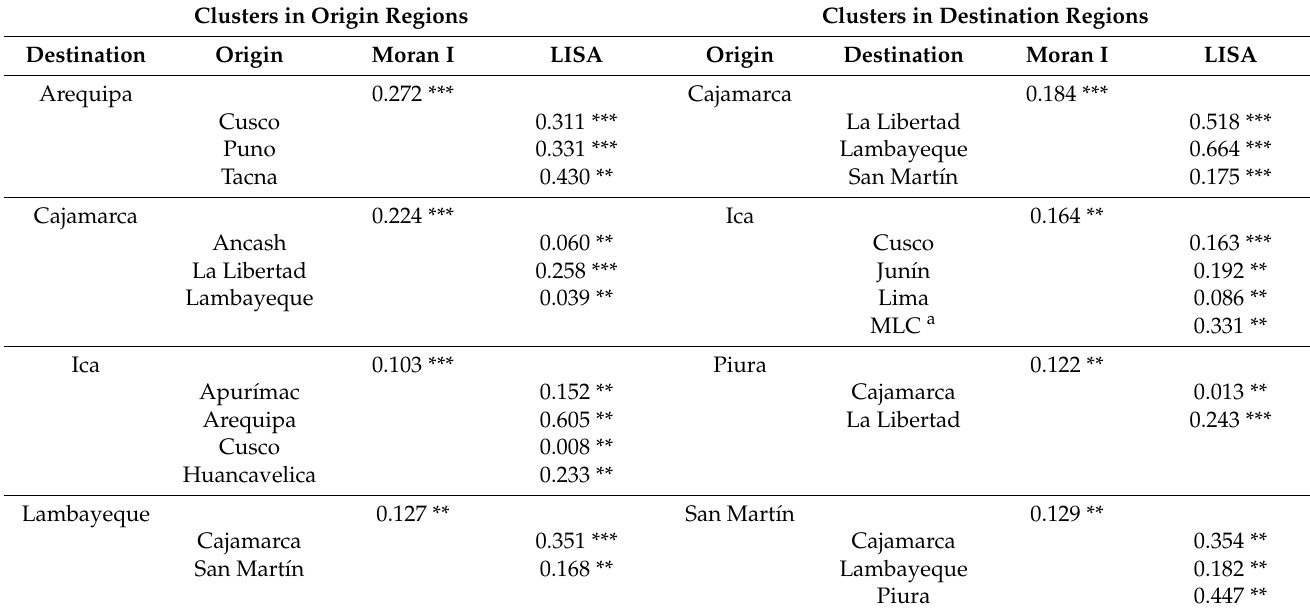
Table 2. Results of the Moran I and LISA tests for origin and destination